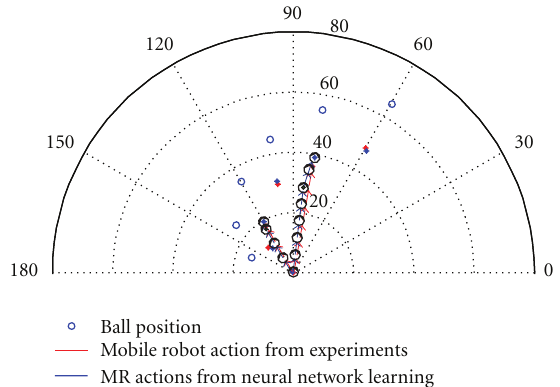
Figure 8: Experimental mobile robot with tracked target on position (55, 80) and (35,